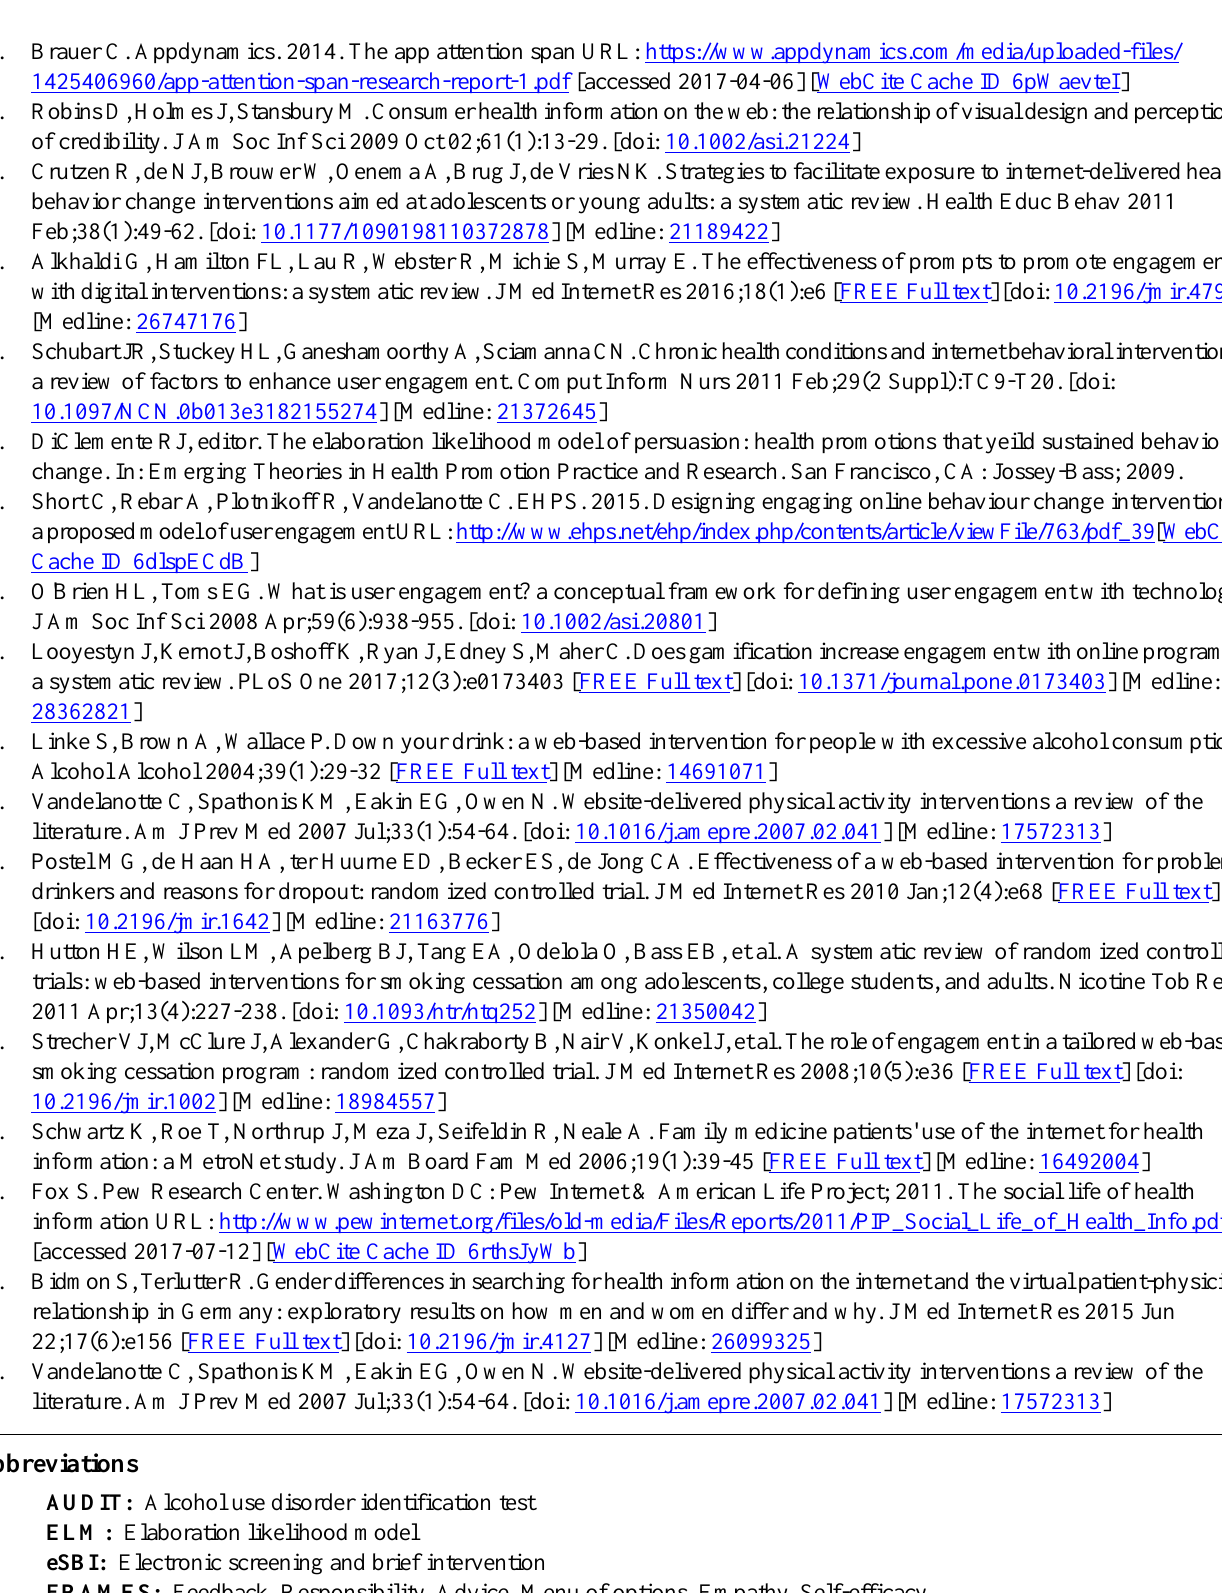
Abbreviations AUDIT: Alcohol use disorder identification test ELM: Elaboration likelihood model eSBI: Electronic screening and brief intervention FRAMES: Feedback, Responsibility, Advice, Menu of options, Empathy, Self-efficacy UCD: User-centered